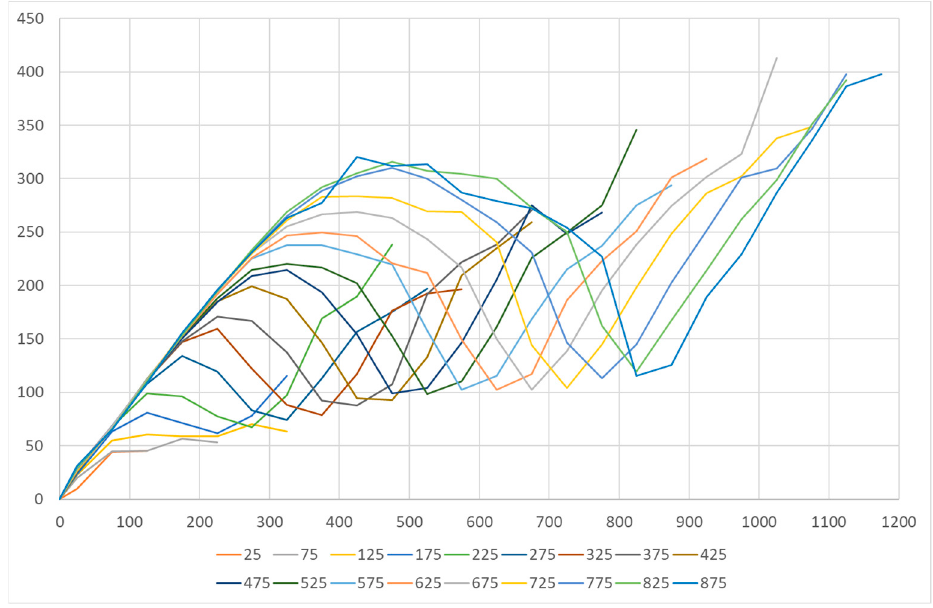
Figure 6. Family of diffuse radiation graphs as a function of total measured radiation .